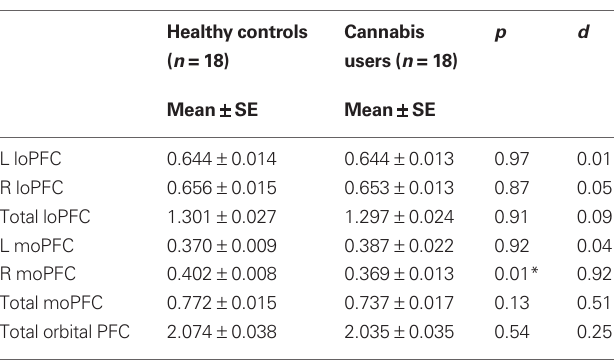
Table 2 | Regions of